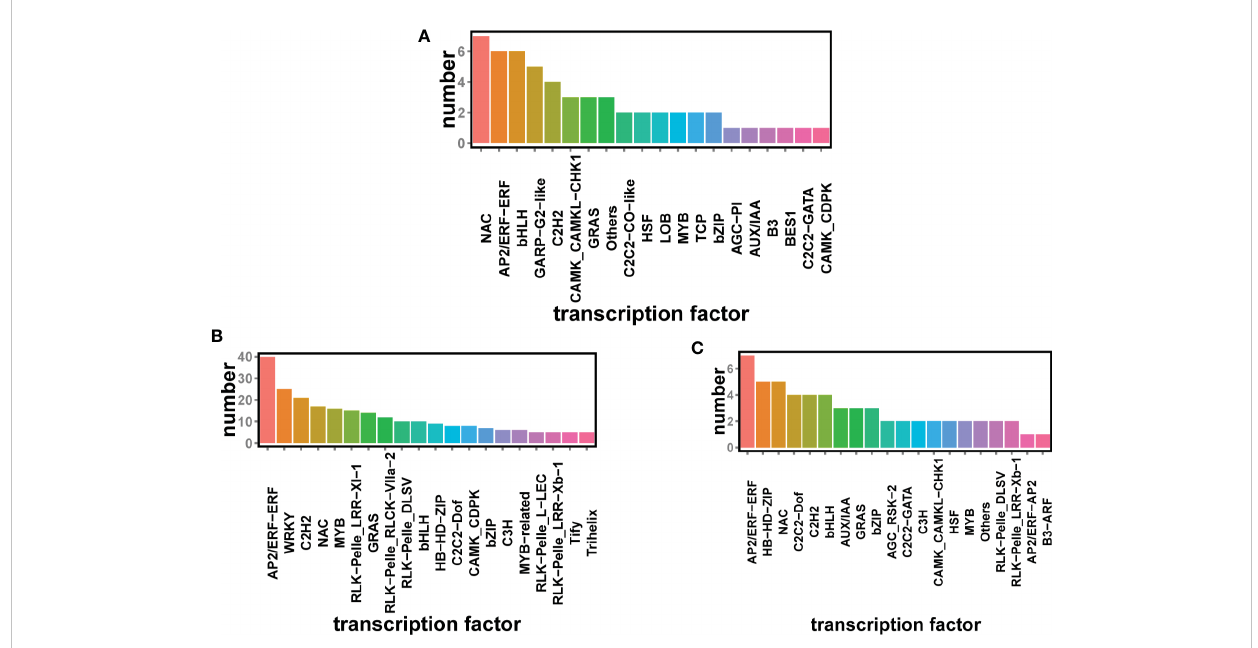
FIGURE 4 Signi fi cant transcription factor (TF) classi fi cation in three tissues of K. obovata seedlings, leaves (A) and roots (B) and stems (C) , before and after chilling, with vertical coordinates representing the number of transcription factors (P < 0.05 and |LOG2FC| > 2).